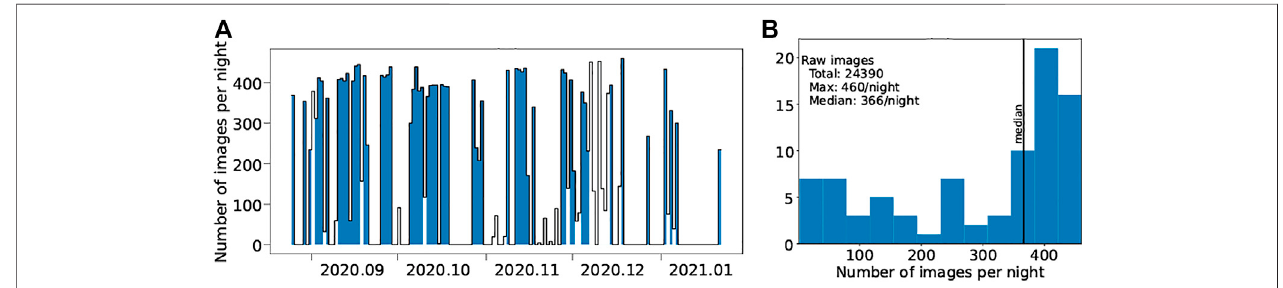
Frontiers in Astronomy and Space Sciences |